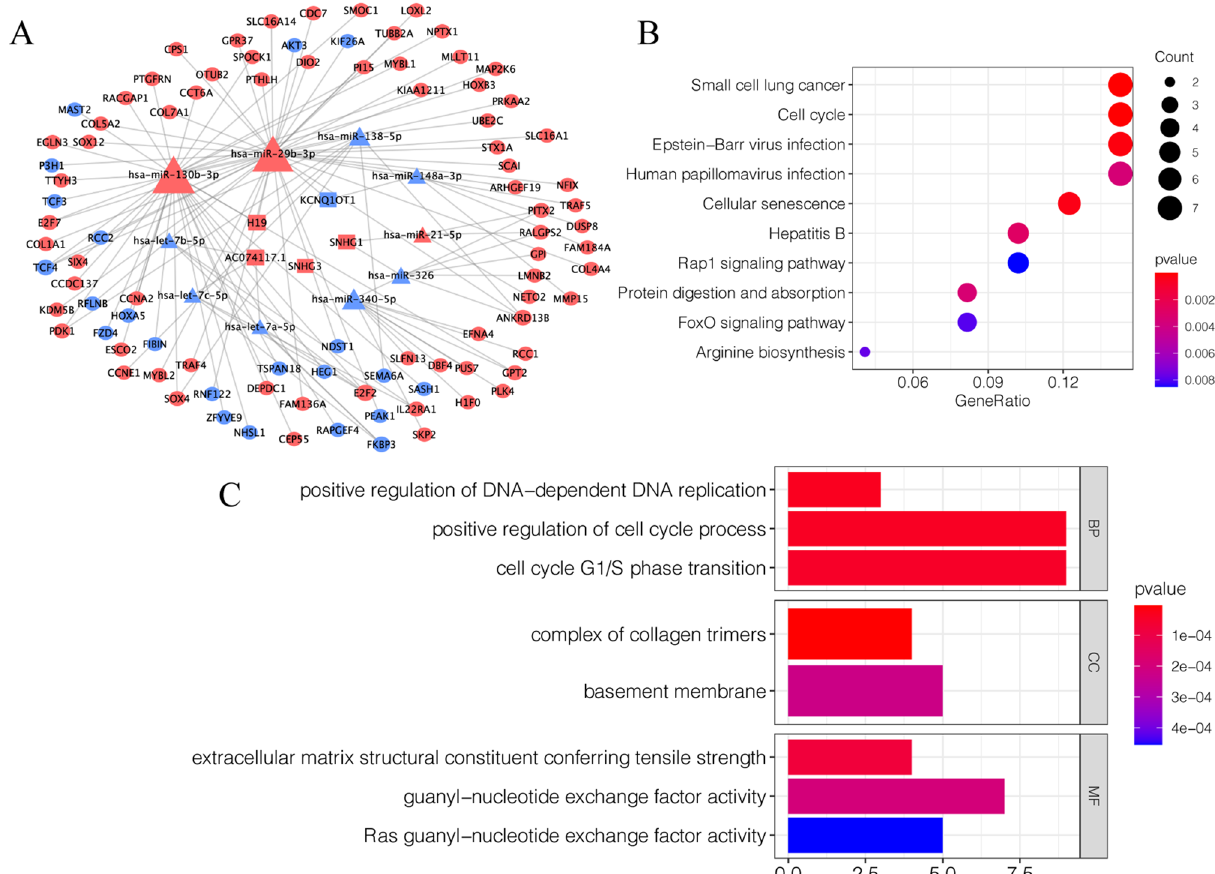
Figure 2. Construction of the ceRNA network and functional enrichment analysis. ( A )The ceRNA network of the differently expressed RNAs in lung carcinoma. The triangle nodes indicate miRNAs; the rectangle nodes indicate lncRNAs; the ellipse nodes indicate mRNAs. The blue nodes indicate down-regulated genes; the red nodes indicate up-regulated genes. Node size indicates the number of the interactions. ( B ) The KEGG enrichment analysis of the ceRNA network genes. ( C ) The GO enrichment analysis of the ceRNA network